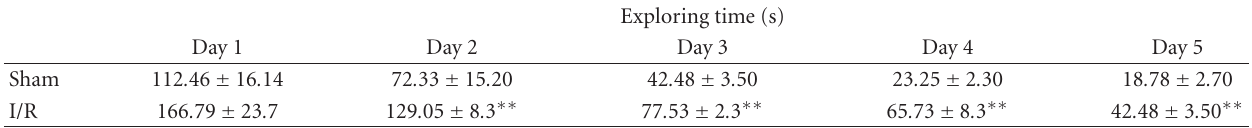
Figure 2: Time-dependent expression of SOD2 in global cerebral I/R rat hippocampus ( n = 4). (a) The relative mRNA level of SOD2 was normalized to endogenous β -actin mRNA for each sample. (b) The relative protein level of SOD2 was normalized to endogenous β -actin protein for each sample. Dates are expressed as mean ± SD of four individual experiments. ∗∗ P < 0 . 01 compared with sham group; ∗ P < 0 . 05 compared with sham group. Table 1: E ff ect of global cerebral I/R on spatial learning and memory in rats ( n =